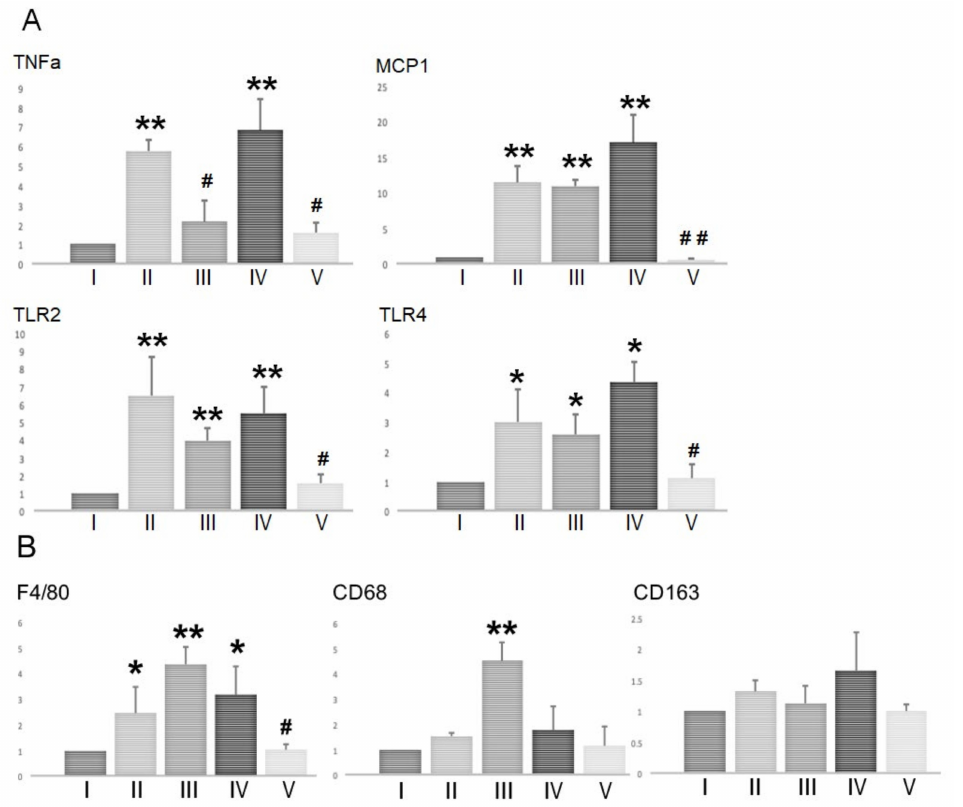
Figure 5. mRNA expression of ( A ) immune mediators and ( B ) macrophage markers in the testes after BSF treatment followed by diet supplementation with Hachimi-jio-gan and / or Hochu-ekki-to. Data represent the mean values ± standard deviation of three mice in independent groups. * p < 0.05 and ** p < 0.01 vs. the control group; # p < 0.05 and ## p < 0.01 vs. the BSF